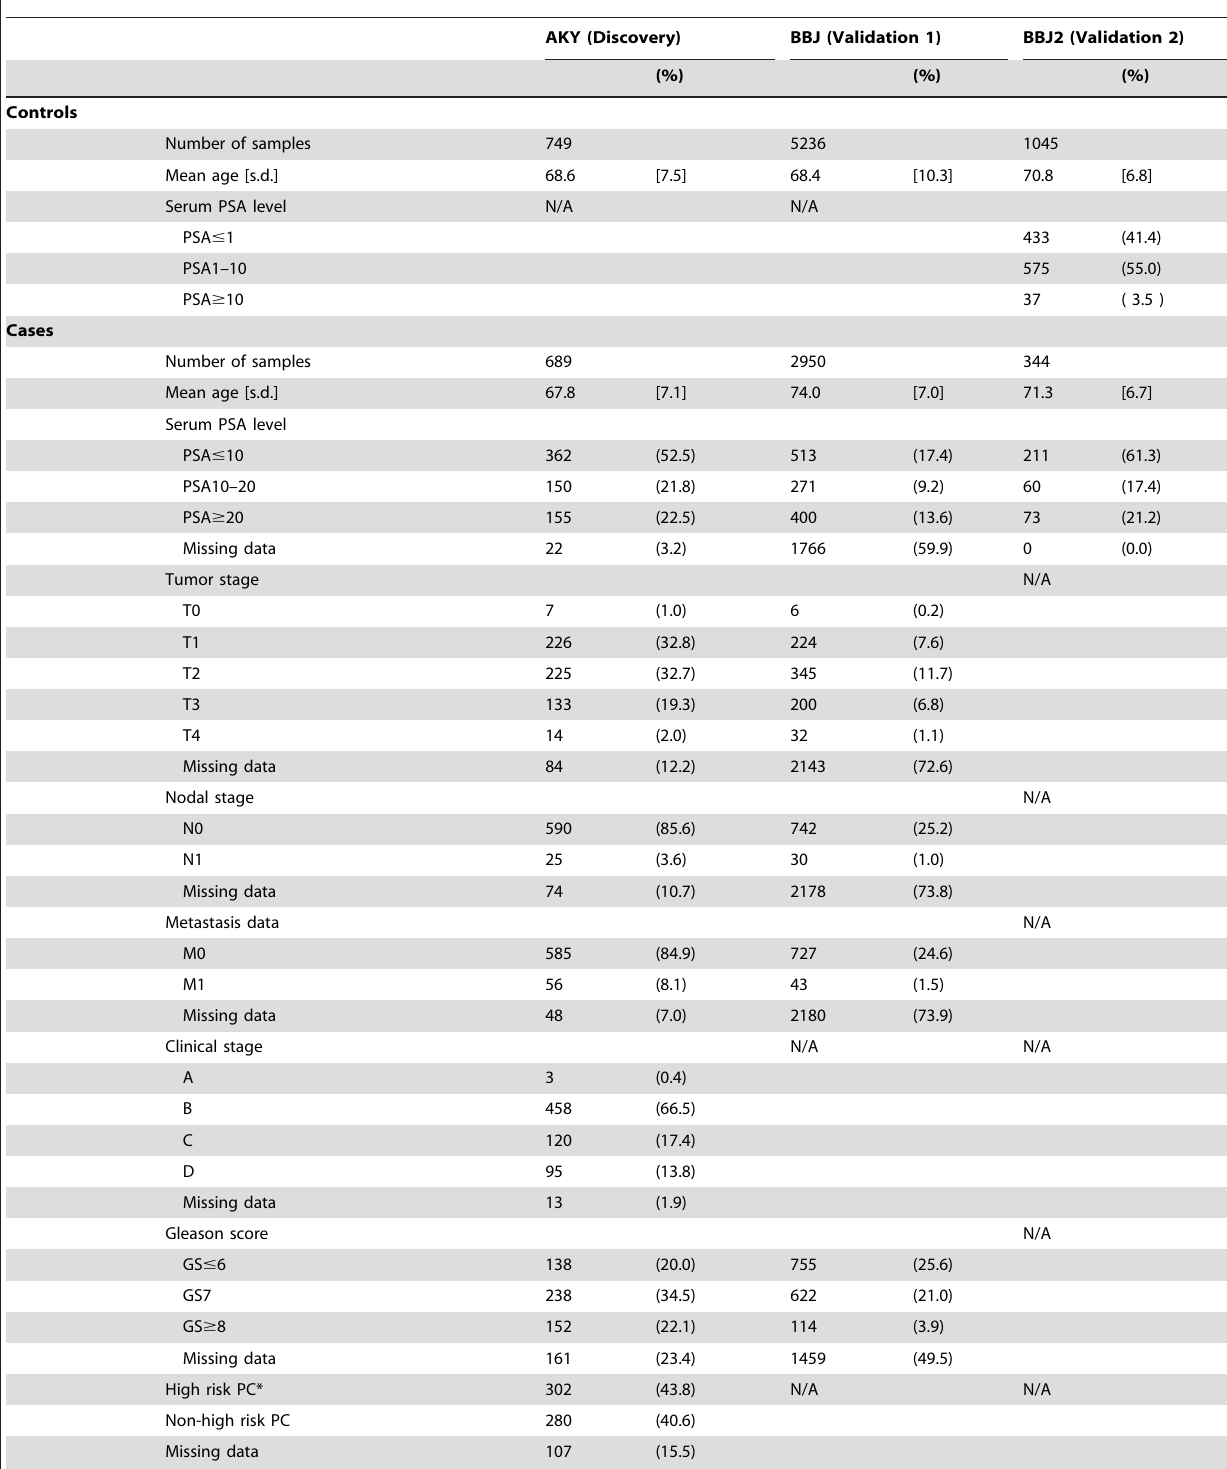
Table 2. Clinical characteristics of the cases and the